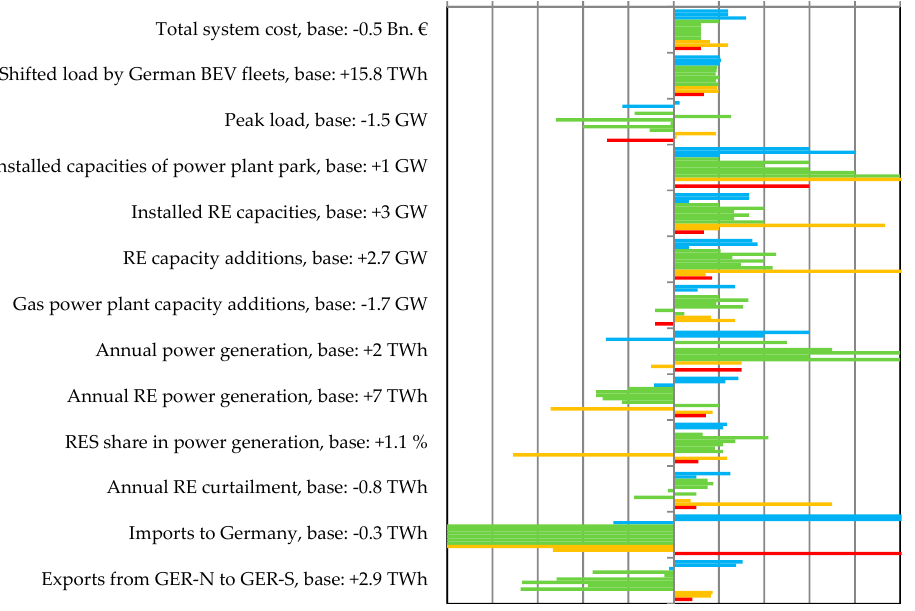
Figure 6. Sensitivity of the difference of REMix model results (categories) between S1 and S2 on German GHG ambitions ( b – d , blue), different underlying weather and electric demand data ( e – j , green), CAPEX assumptions ( k – l , yellow) and controlled charging in S1 ( m , red). Values between 0 and 100% indicate decrease in difference, values above 100% indicate increased difference, and values below 0 indicate an inversion.